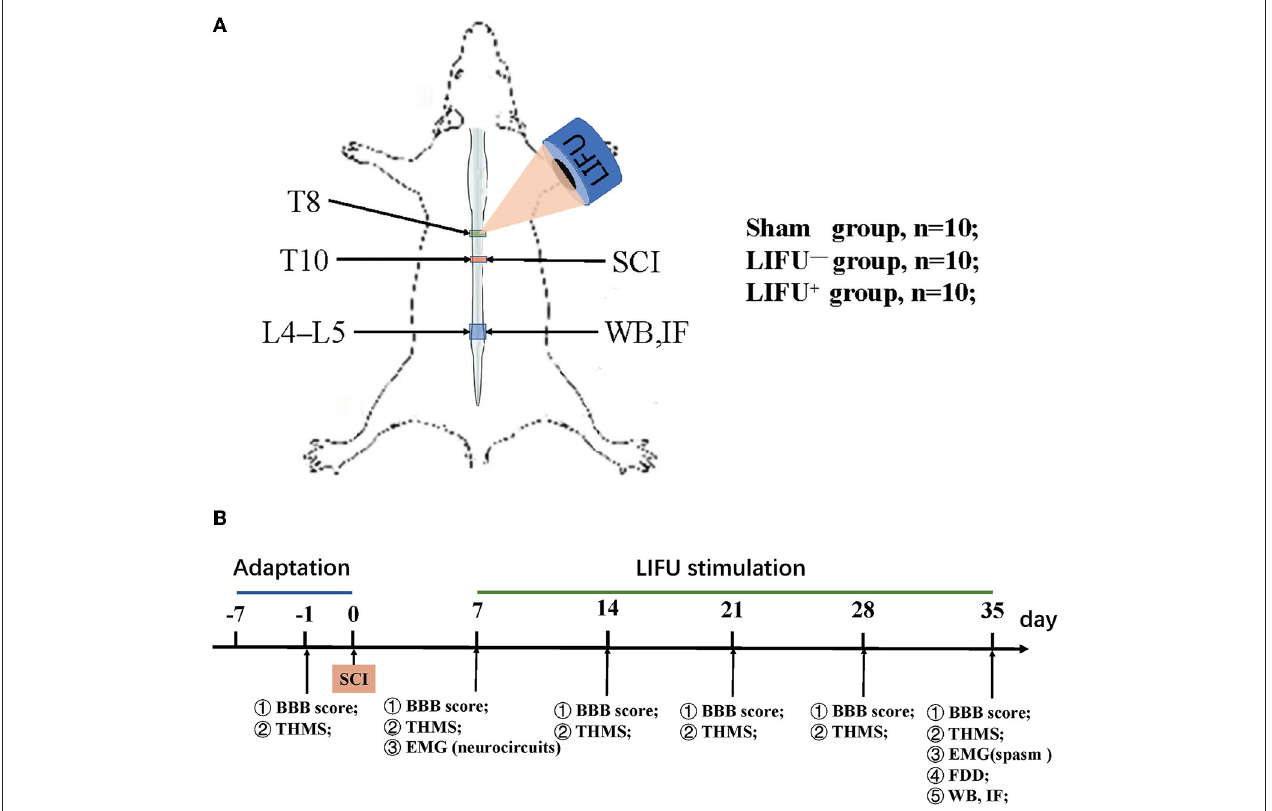
FIGURE 1 | Experimental design of the study. (A) Modeling and ultrasound therapy. (B) Experimental design. The Basso, Beattie, and Bresnahan (BBB) score and threshold hold (g) of mechanical stimulation (THMS) were tested 1 d before the spinal cord injury (SCI) and weekly starting from 7 d post-injury (dpi); electromyography (EMG) of the neurocircuits and spasm were tested before/after low-intensity focused ultrasound (LIFU) treatment separately; frequency-dependent depression (FDD), western blot (WB), and immunofluorescence (IF) staining were tested following the end of LIFU treatment.